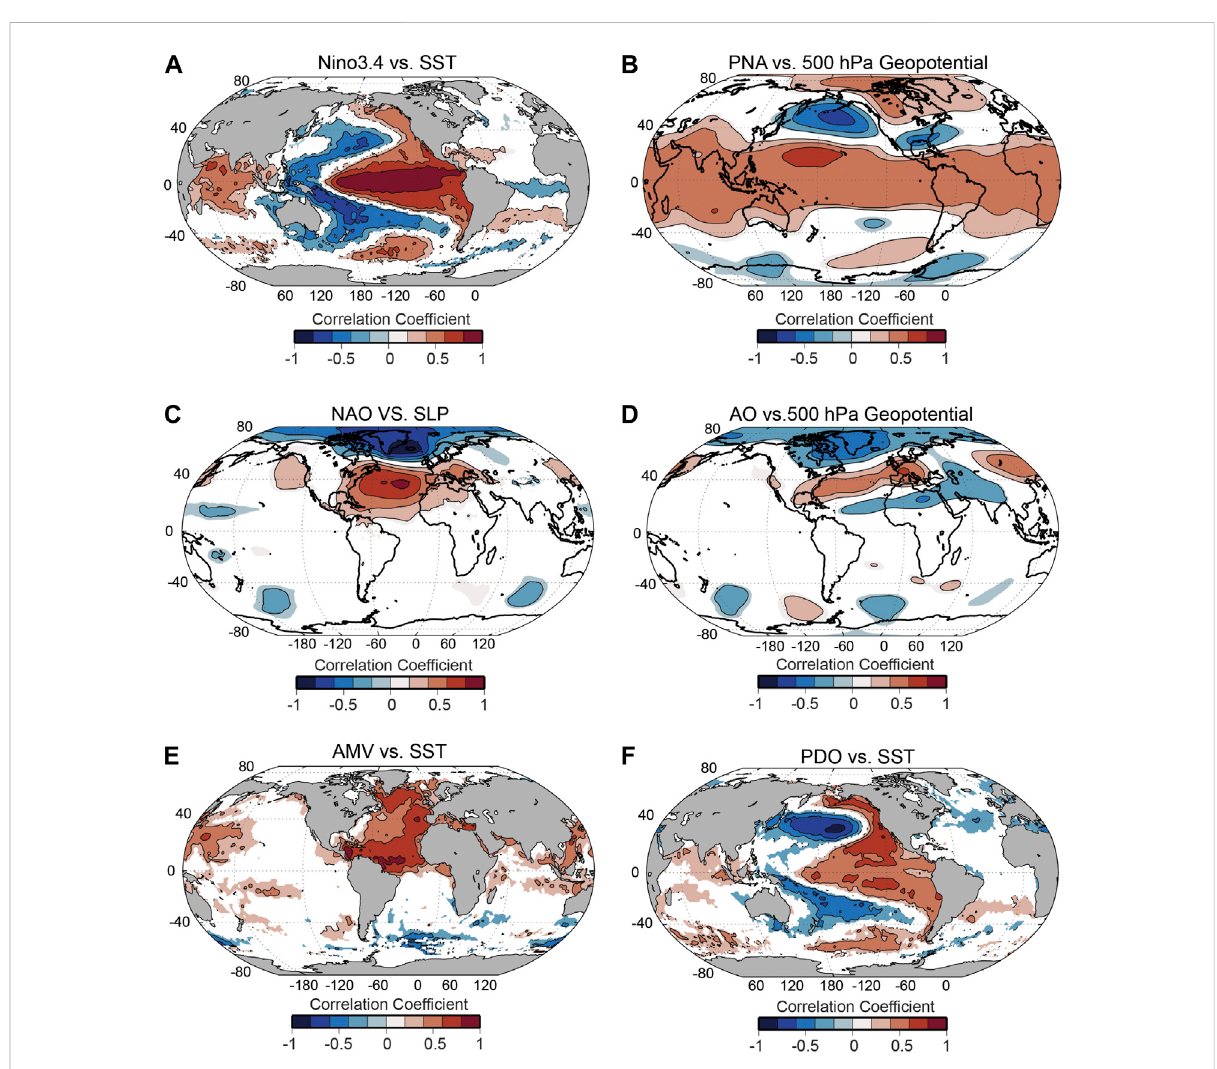
Centers of action for Nino3.4 (A) , AMV (E) , PDO (F) , identi fi ed by mapping their correlations with Hadley sea surface temperature (SST; https:// www.metof fi ce.gov.uk/hadobs/hadisst/); NAO (C) , identi fi ed by mapping its correlation with sea-level pressure (ERA5; https://cds.climate. copernicus.eu/); and PNA (B) and AO (D) , identi fi ed by mapping their correlations with 500 hPa geopotential (ERA5; https://cds.climate.copernicus. eu/). Only regions where correlations were signi fi cant (alpha = 0.1) are shown on the